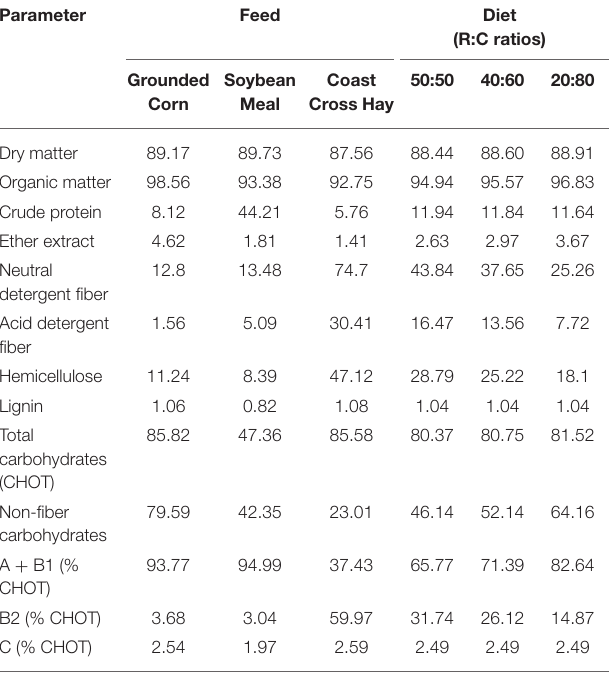
TABLE 2 | Chemical composition and carbohydrate fractionation of feed and diets containing rosemary and garlic essential oils, as basis dry matter (%). Parameter Feed Diet (R:C ratios) Grounded